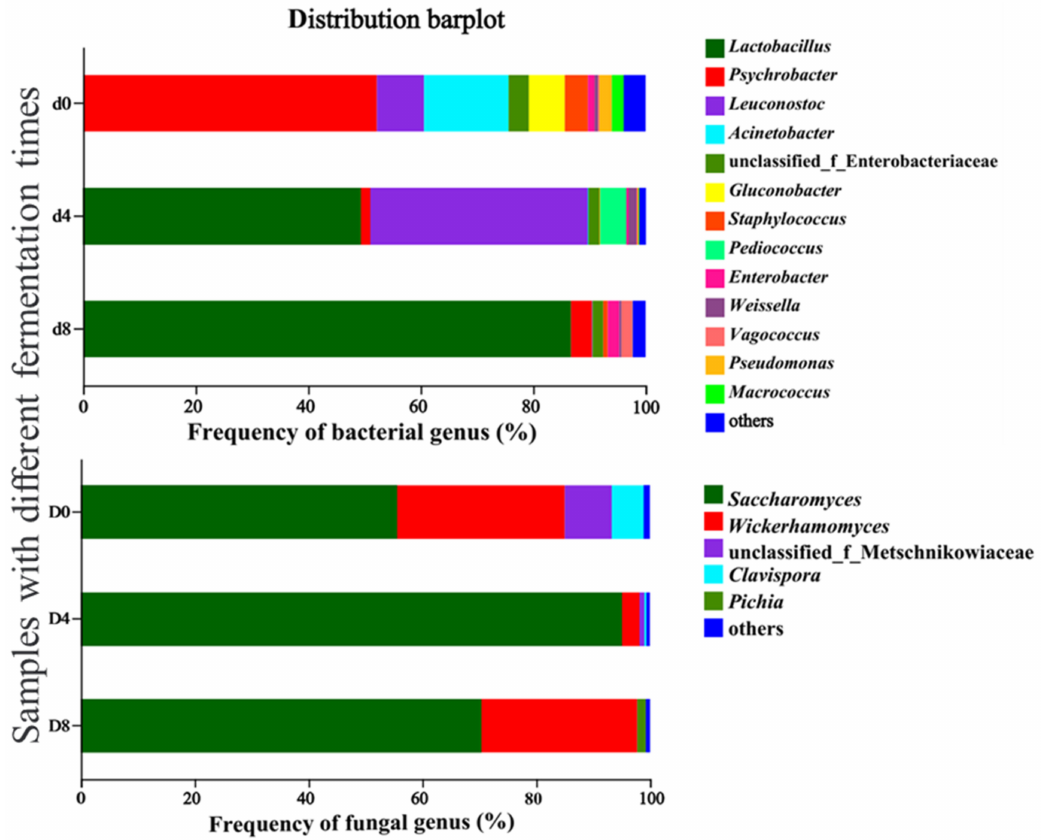
Figure 5. Barplots of bacterial and fungal diversity of vinasse hairtail at the genus level. Others: The